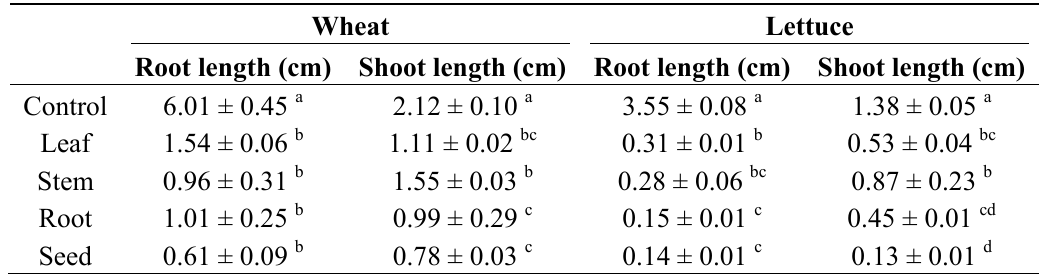
Table 1. Phytotoxic effects of ethanol extracts of different plant parts of P. harmala at 0.05 g/mL.